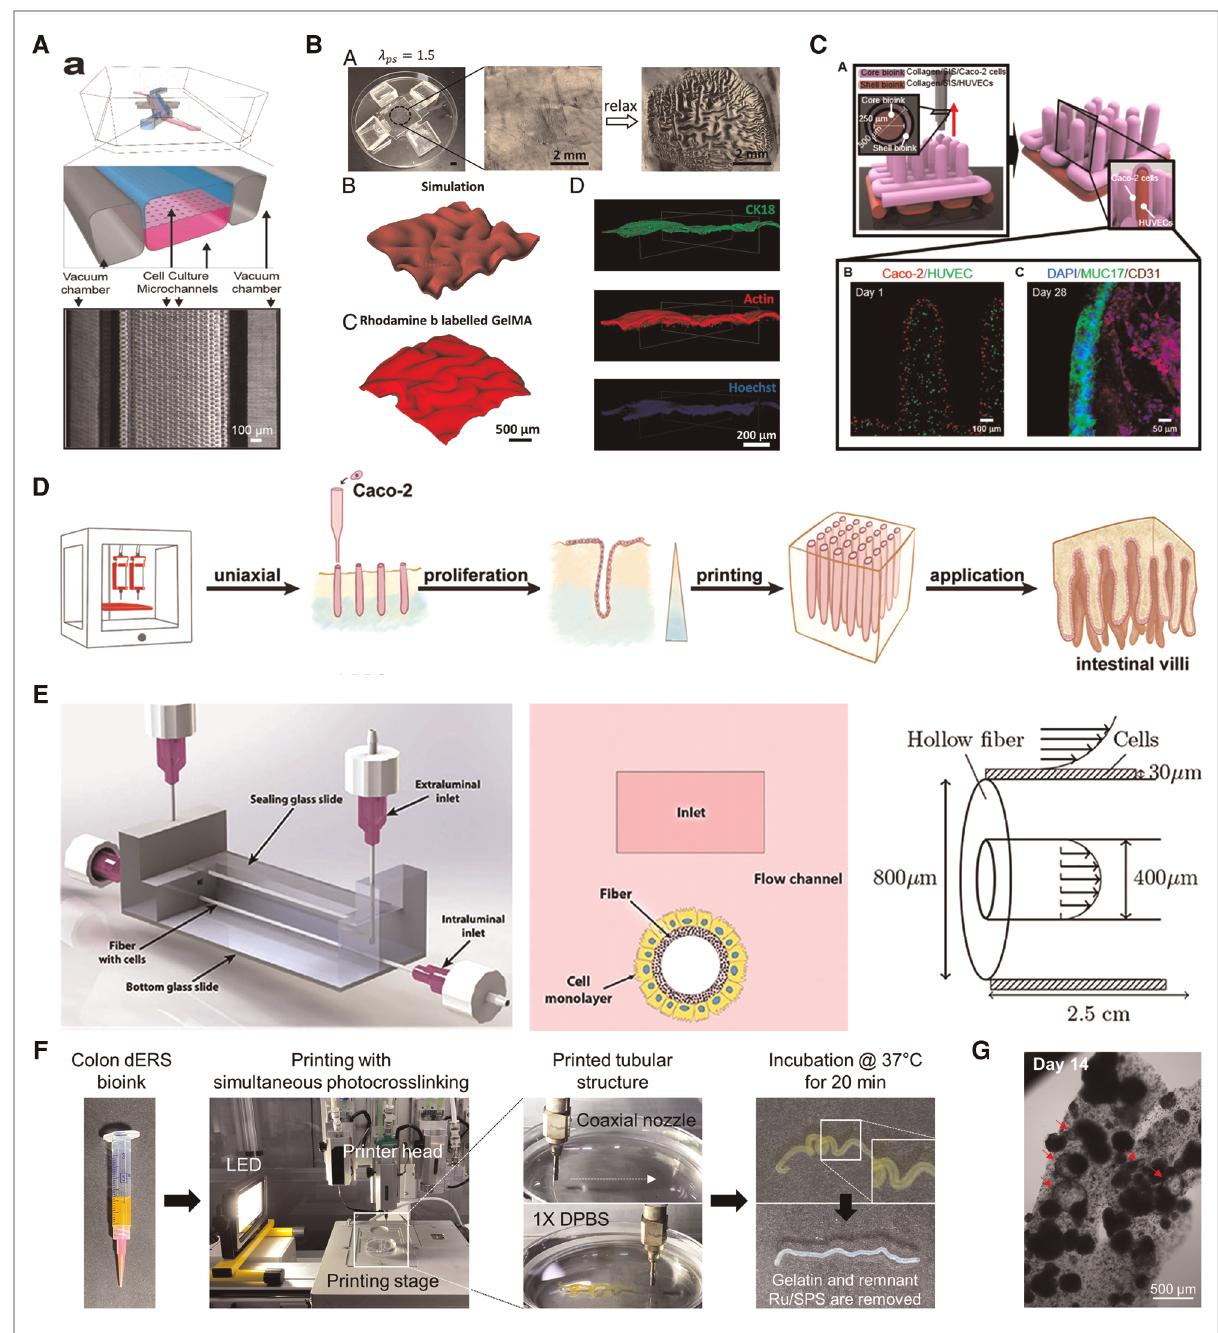
FIGURE 3 Biofrbrication technologies for in vitro gut models. ( A ) Quasi-3D microphysiological systems. Reproduced from Kasendra et al. (56). Open access (CC-BY). ( B ) 3D topography patterning. Reproduced from Chan et al. (57). with permission from the author. ( C ) 3D direct bioprinting. Reproduced from Kim et al. (58). Open access (CC-BY 4.0). ( D ) 3D embedded bioprinting. Adapted from Lian et al. (59) with permission from the publisher. ( E ) 3D hollow scaffold. Reproduced from Langerak et al. (60). Open access (CC-BY 4.0). ( F,G ) 3D coaxial bioprinting assisted with photocrosslinking. Reproduced from Han et al. (61) with permission from the